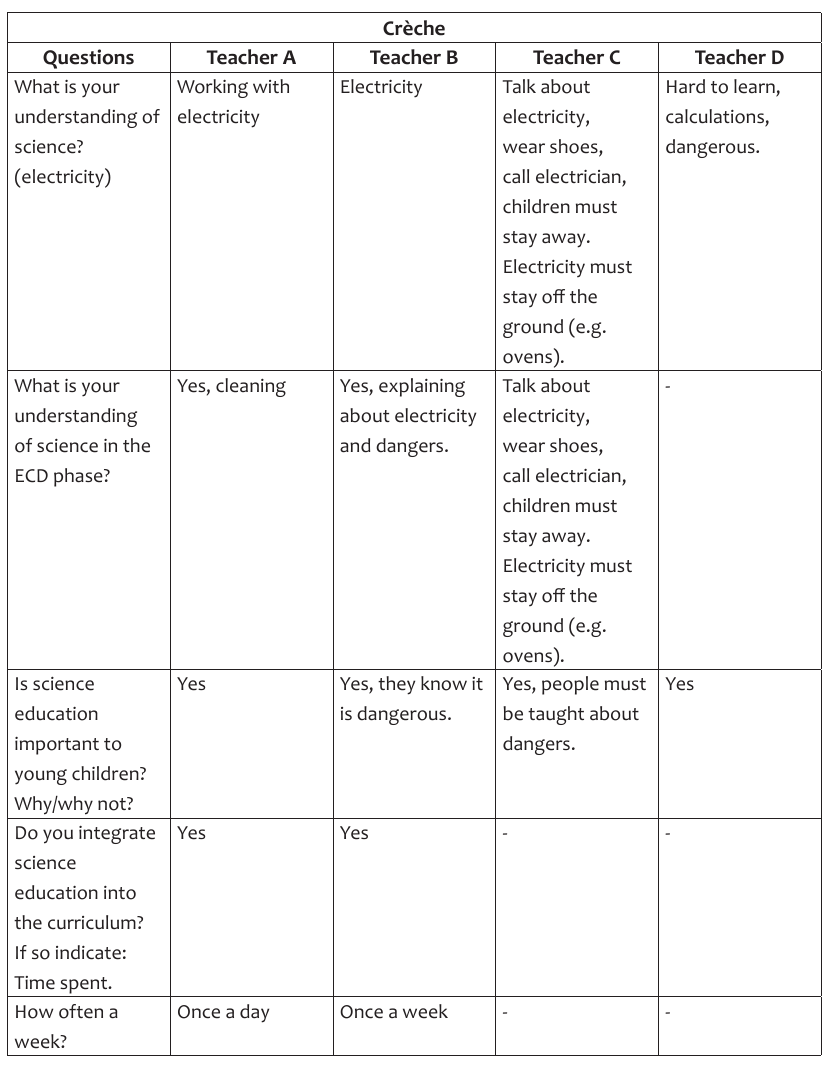
Table 5: Teachers responses